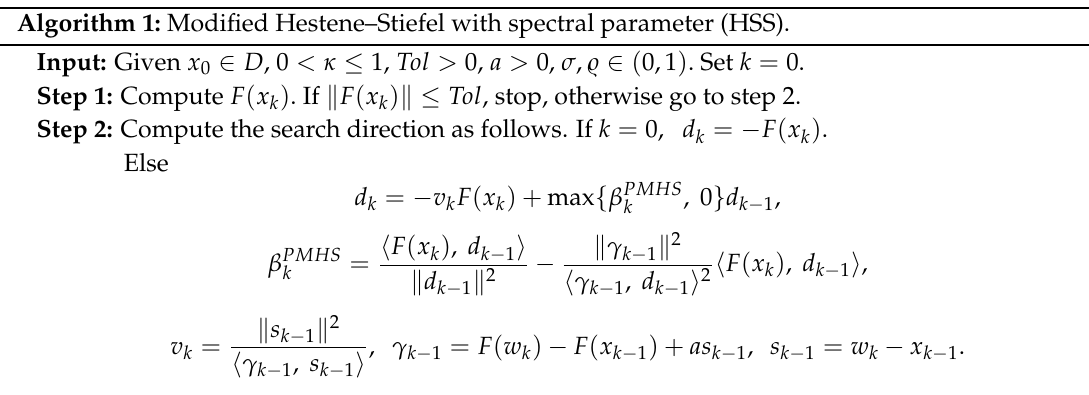
Algorithm 1: Modified Hestene–Stiefel with spectral parameter